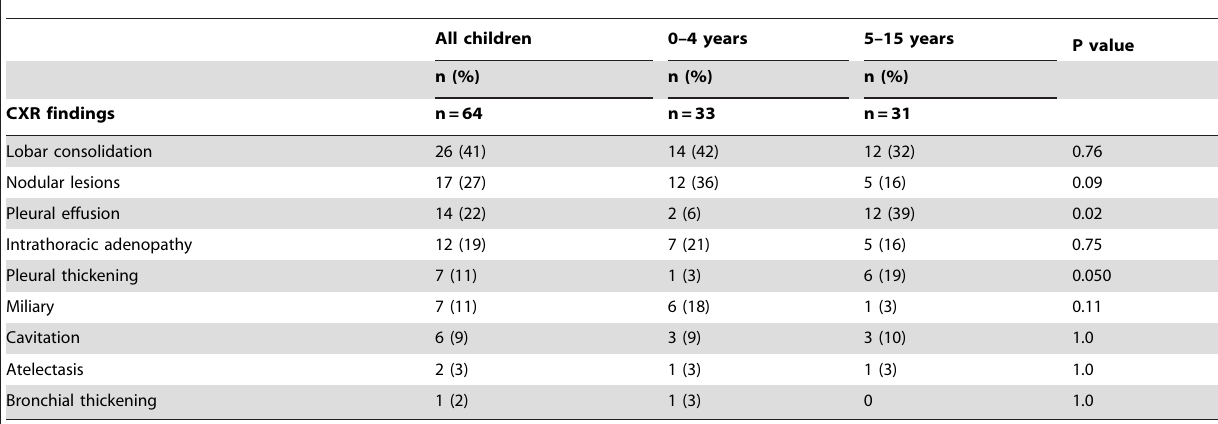
Table 4. CXR Findings in Those with Intrathoracic TB According to Age.